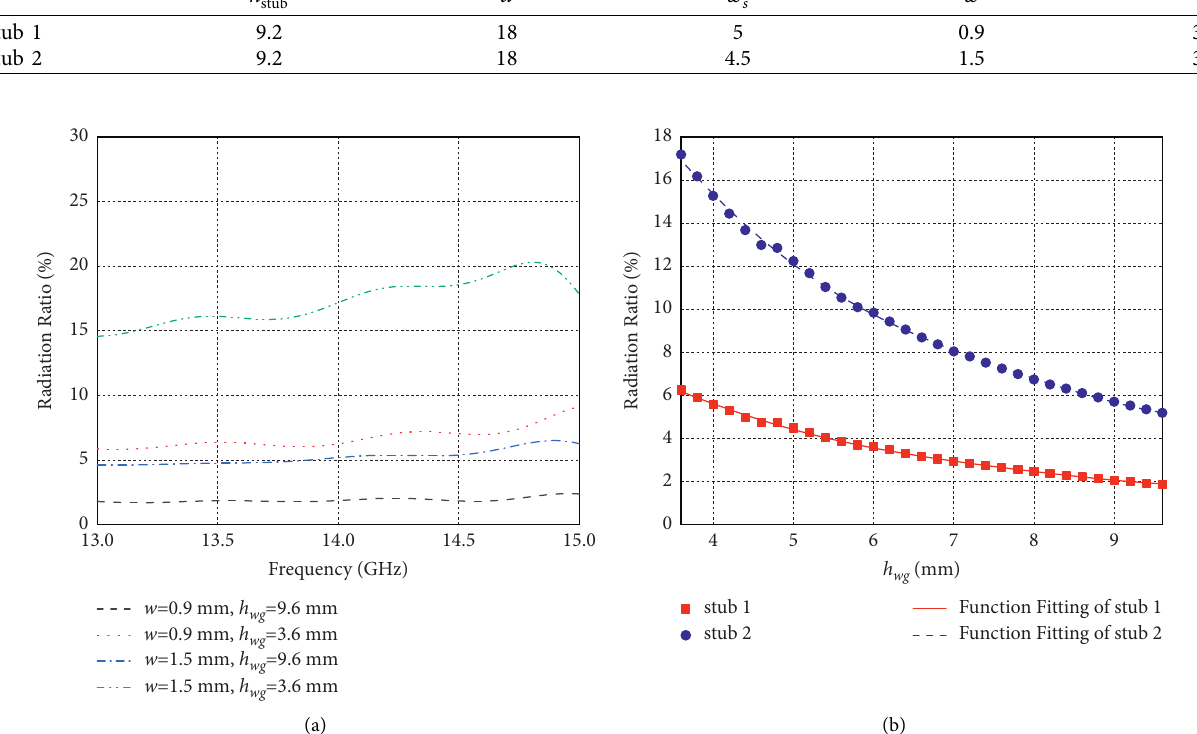
Figure 3: Radiation ratio of stubs. (a) Radiation ratio at different frequencies. (b) Relationship between radiation ratio and h